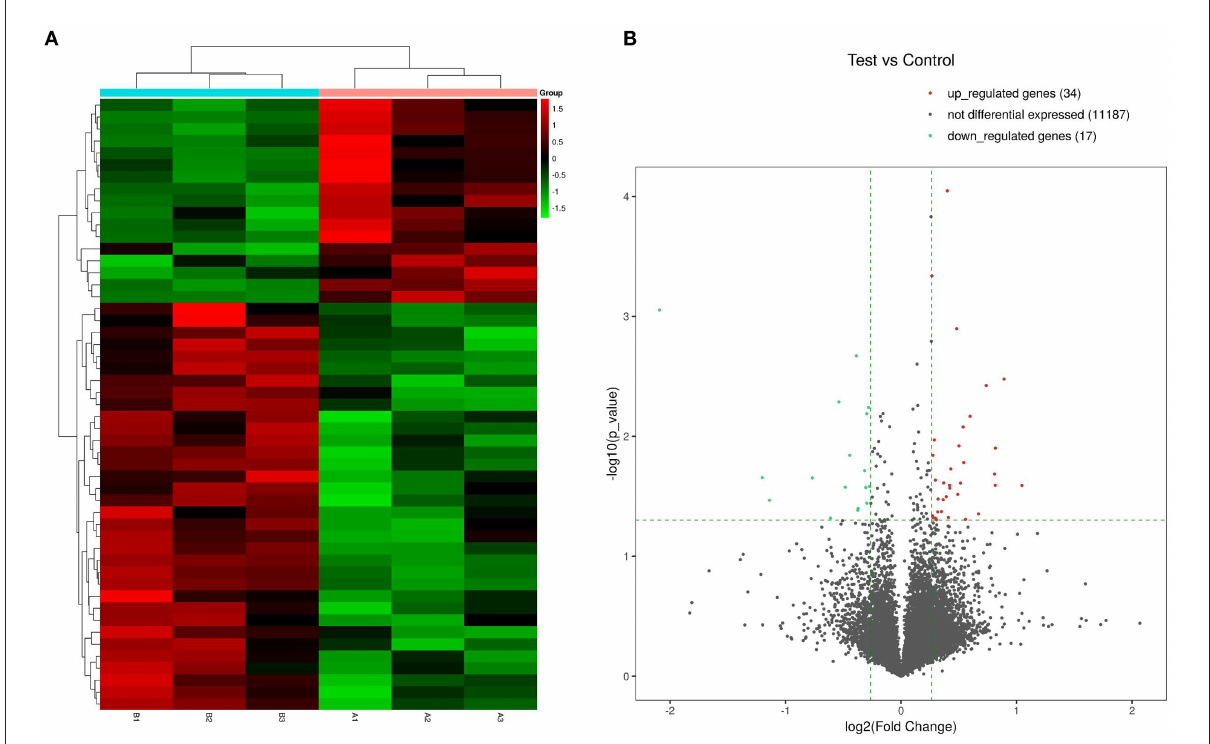
FIGURE1 Heatmaps and volcano plot of DEGs in C3G-treated vs. untreated control MC3T3-E1 cells. (A) Heatmap of 34 upregulated and 17 downregulated DEGs. (B) Volcano plot of upregulated (red dots) and downregulated (green dots) DEGs and genes expressed at a normal level (gray dots).